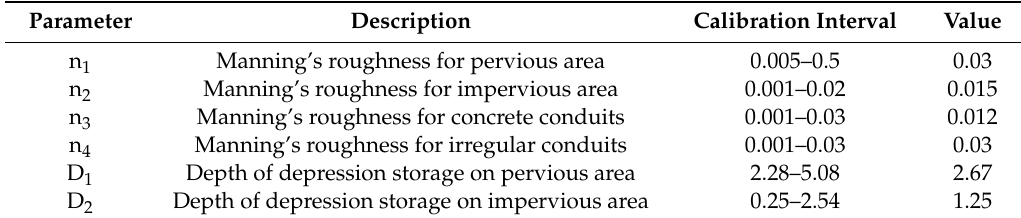
Table 1. Calibrated parameters of the Storm Water Management Model (SWMM) model.